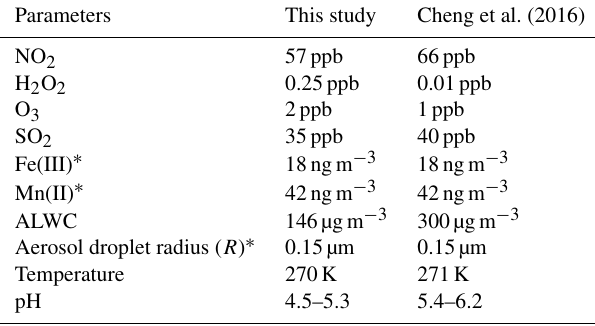
Table 2. The comparisons of parameters of sulfate production rate calculations between in the study of Cheng et al. (2016) and in this work during the most polluted haze